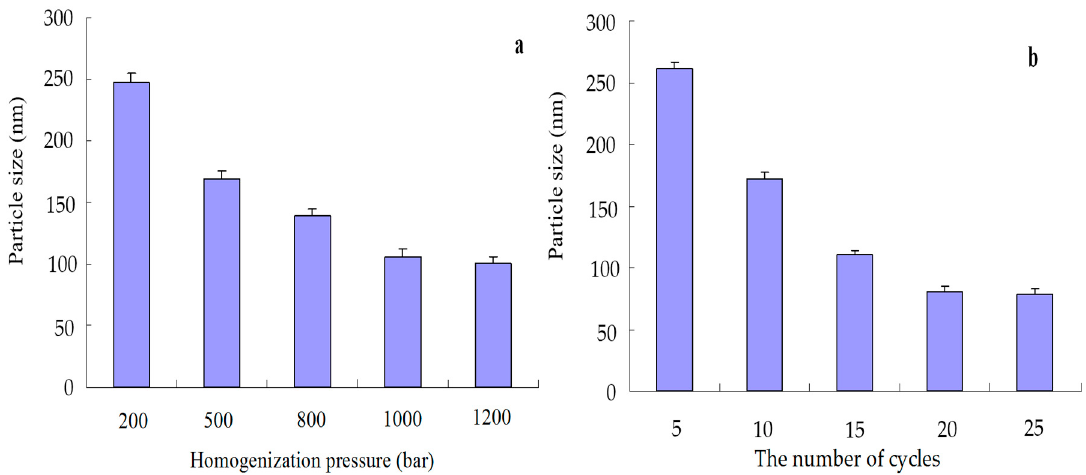
Figure 3. Effect of homogenization pressure ( a ) and homogenization cycles ( b ) on the particle size of vitexin nanosuspensions.